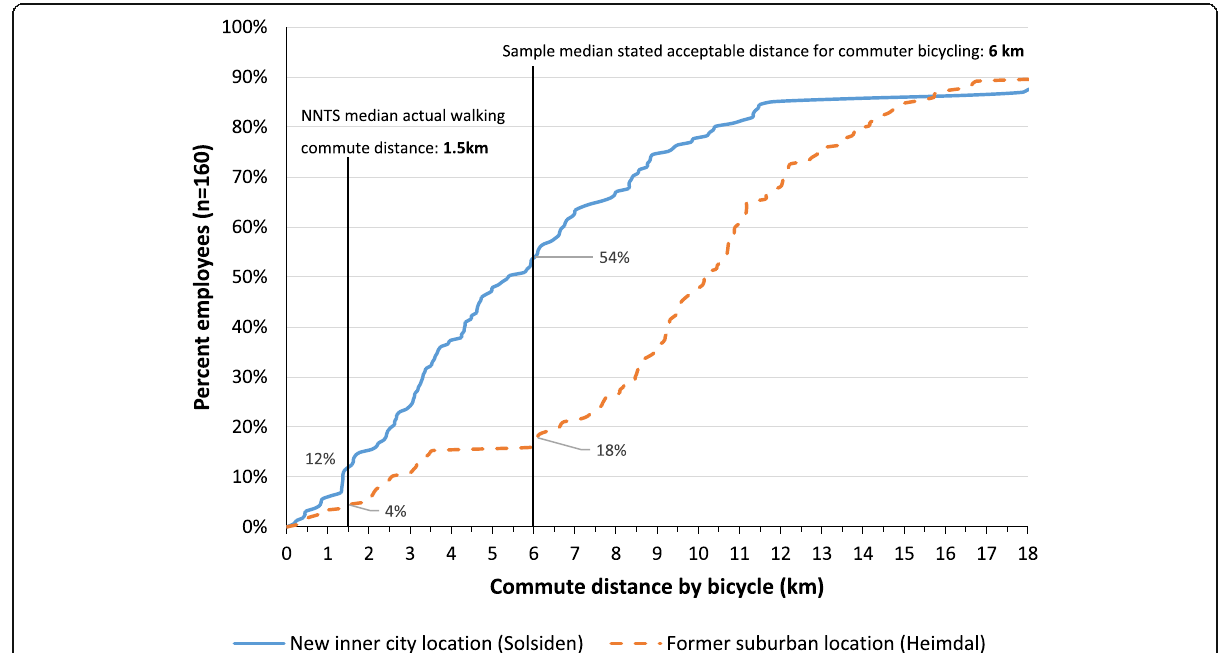
Fig. 7 Cumulative distribution of commute distance from unique Adresseavisen employee addresses ( n = 160) to the former and present location. Distances are calculated from a GIS operation minimising the Bicycle Level of Traffic Stress